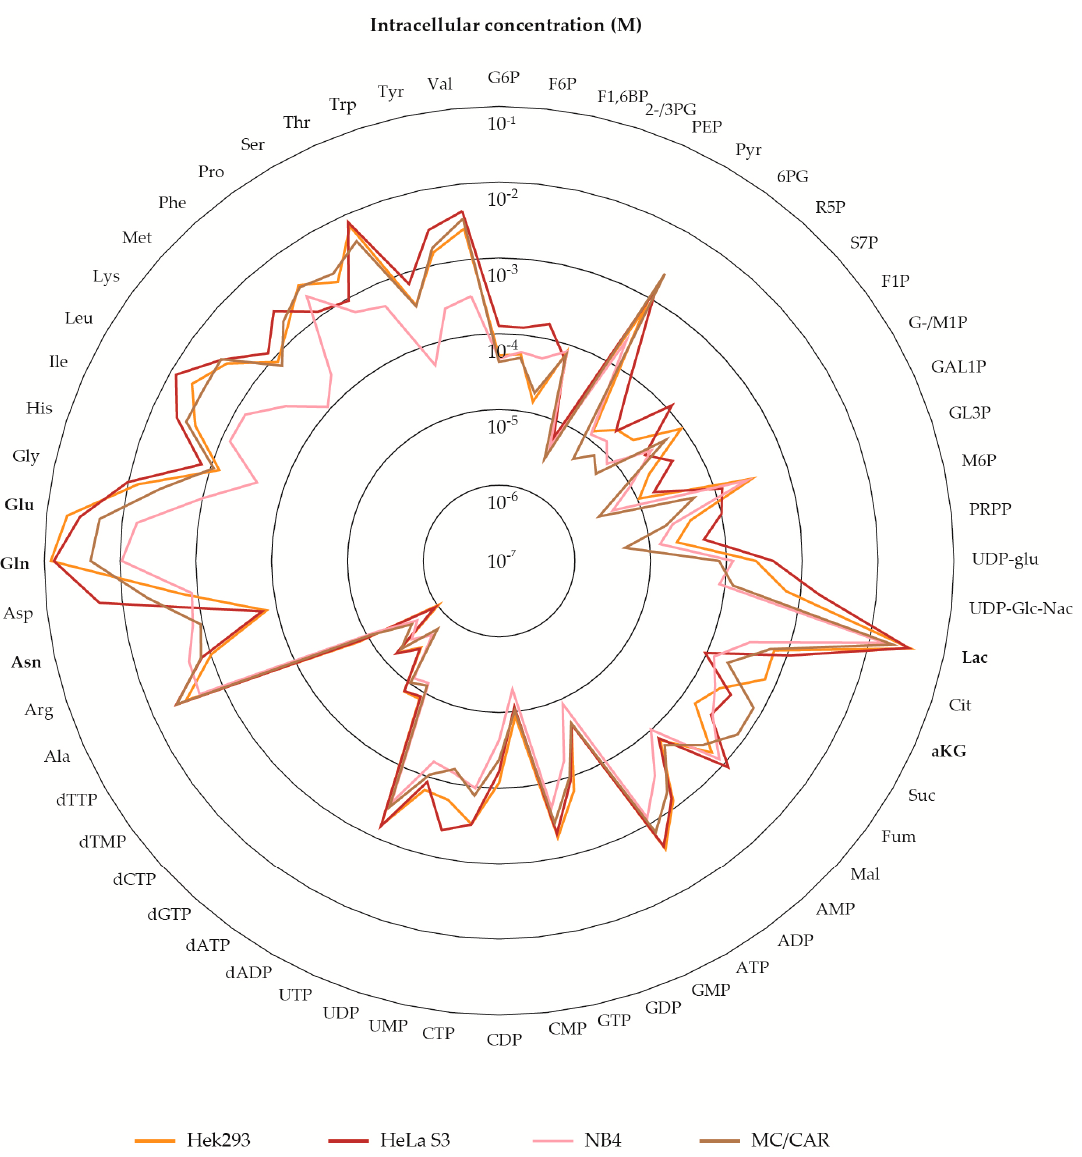
Figure 6. Log 10 -transformed average metabolite pool sizes of the Hek293, HeLa S3, NB4, and MC/CAR cell lines. Metabolites in bold are mentioned in the text. Metabolite abbreviations are listed in Table S1.